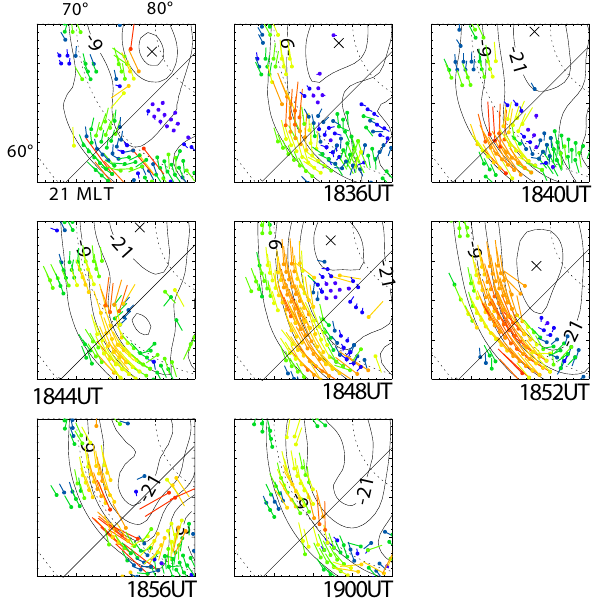
Fig. 8. SuperDARN map potential plots at four-minute intervals with the true vectors superposed from 18:32 until 19:00 UT on 1 September 2002.